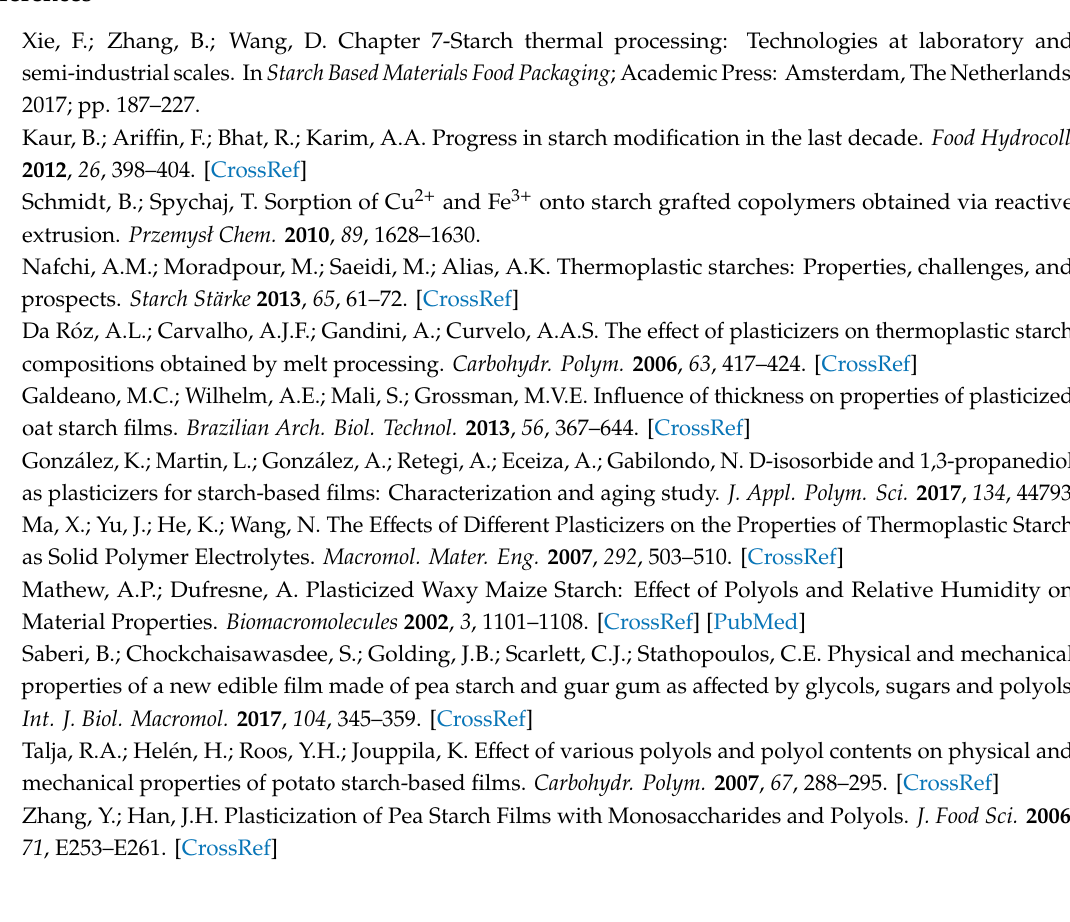
Figure S1. TG (solid) and DTG (dash) curves for PS / S:CC 1:2 premixtures; Figure S2. DSC curves for PS / S:CC 2:1 premixtures after di ff erent preheating parameters; Figure S3. DSC curves for PS / S:G 1:2 premixtures after di ff erent storage time; Figure S4. DSC curves for PS / polyol premixtures; Figure S5. Mechanical properties for thermocompressed films: A-TPS / S:CC 1:1 and B-TPS / S:CC 2:1with di ff erent preheating parameters; Table S1. Mechanical tests results for films based on preliminary extruded TPS / S:CC (2:1 molar ratio) films; standard deviations values in brackets; Figure S6. XRD patterns for TPS / S:CC films obtained after extrusion (100 rpm) with A: TPS / S:CC f (extruded composition without conditioning) after preparation and 12 months of storage; B: TPS obtained after extrusion with di ff erent plasticizers; Table S2. Bands maxima shifts in FTIR spectra of DES, native starch and TPS / S:CC 2:1 films obtained via two di ff erent